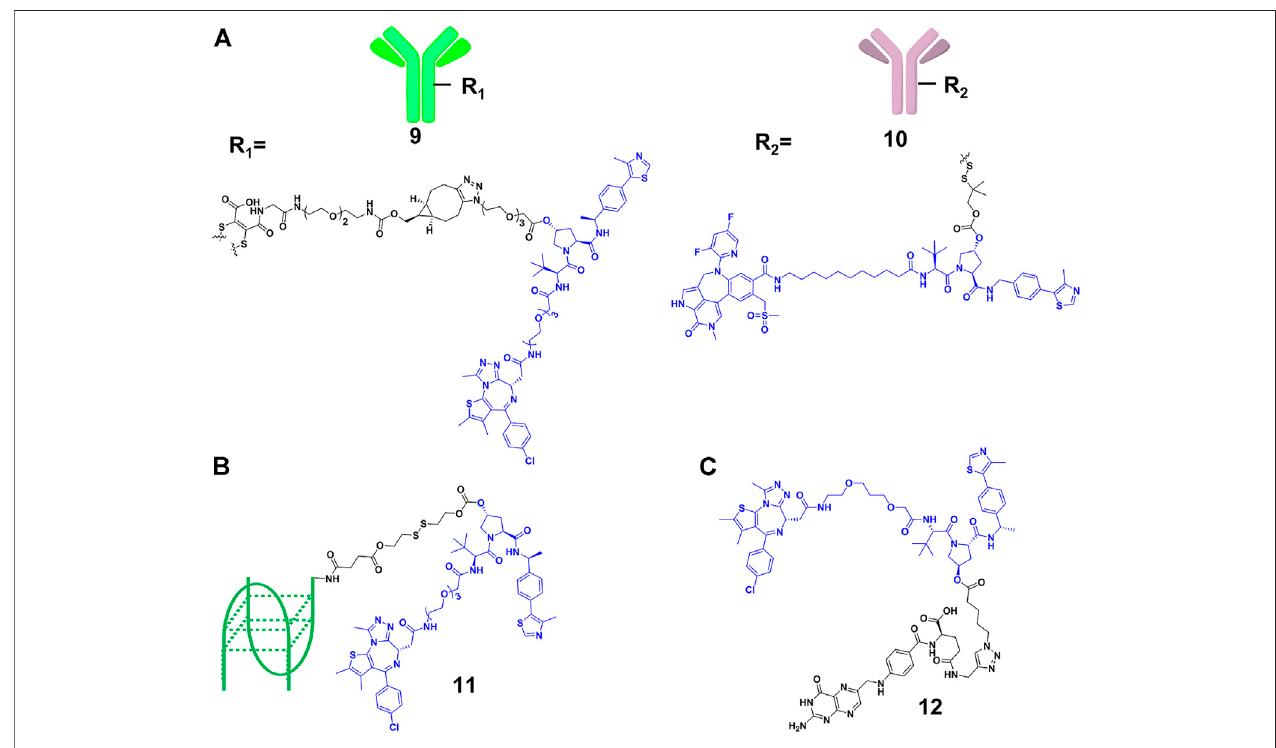
FIGURE 5 | (A) Structure of antibody-PROTAC Conjugates. (B) Structure of aptamer-PROTAC Conjugates. (C) Structure of folate-PROTAC Conjugates.